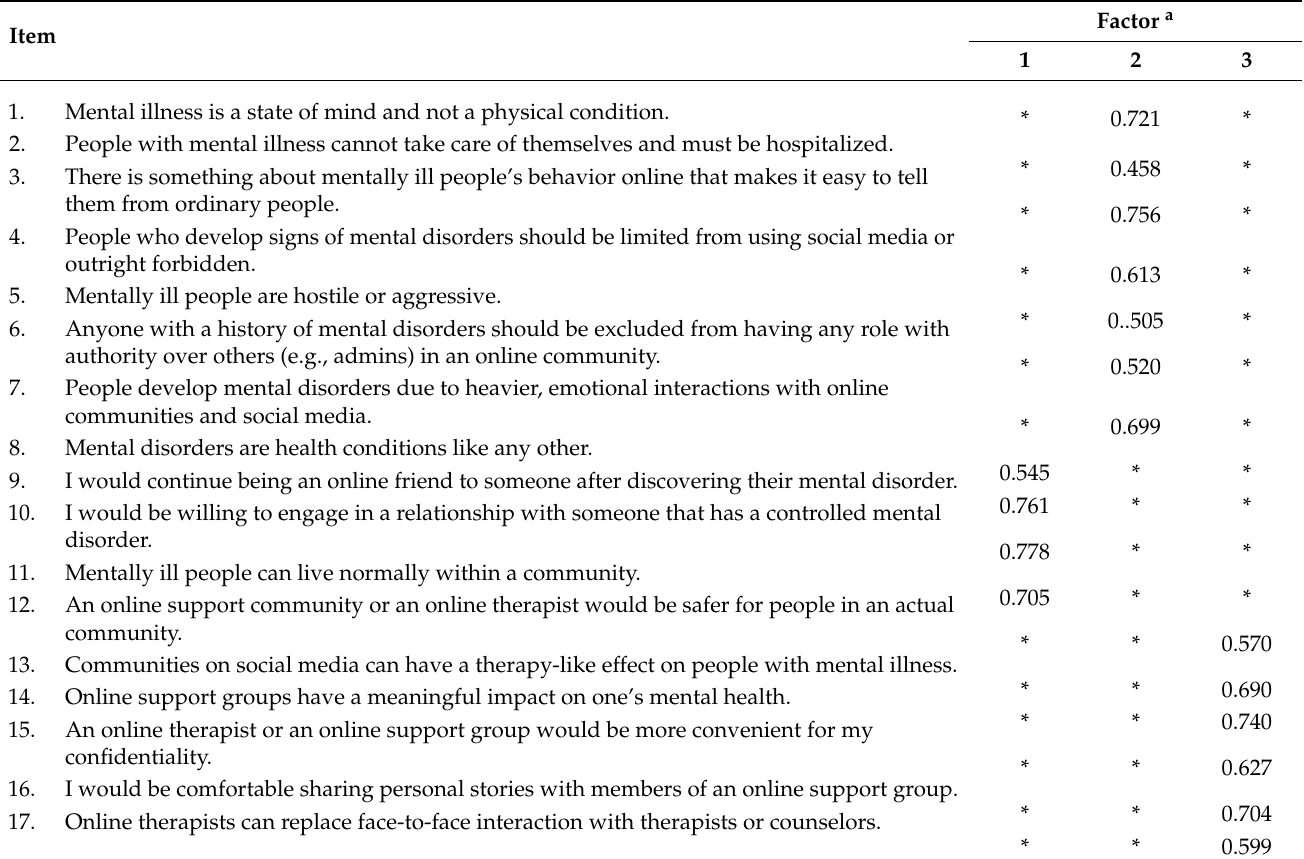
Table 2. Rotated factor loadings for current